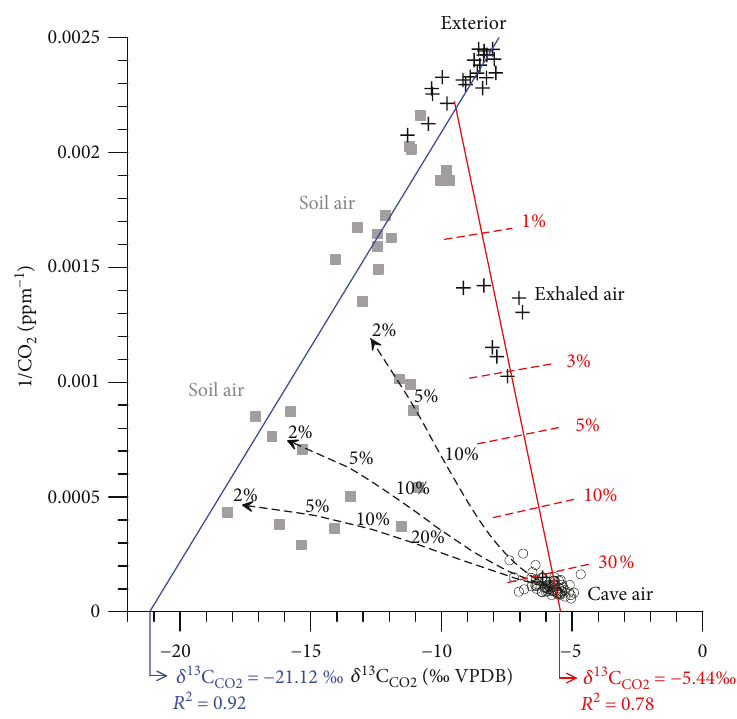
Figure 6: Plot of 1/CO versus δ 13 C for soil (grey squares) and cave air (open circles). The composition of the local atmosphere is 2 CO2 indicated by crosshairs, distinguishing those samples of exhaled air collected just inside the cave entrance. The Keeling functions fi t the set of data points representing a two-component mixture of average atmospheric air with an additional source of CO , either the pure 2 component from the soil (blue straight line, without considering the dispersed data point towards cave air), or from deep endogenous air of the CO source: soil-derived CO ( − 21.12 ‰ , R 2 = 0 92 ) and (red straight line). Extrapolation down to the X -axis yields the δ 13 C CO2 2 2 deep endogenous CO ( − 5.44 ‰ , R 2 = 0 78 2